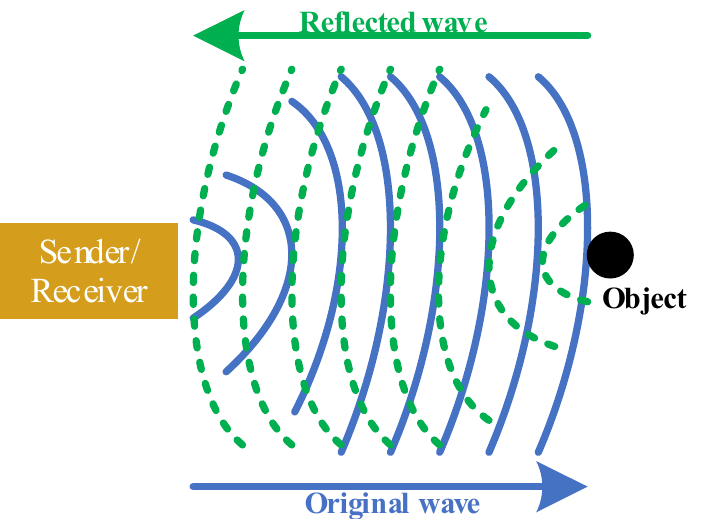
Figure 1. Graphical abstract of the operation of PZETs in underwater transmission systems. Zero-voltage and current-switching strategies are two advanced switching methods of decreasing the switching losses of a converter and helping switches to work in their